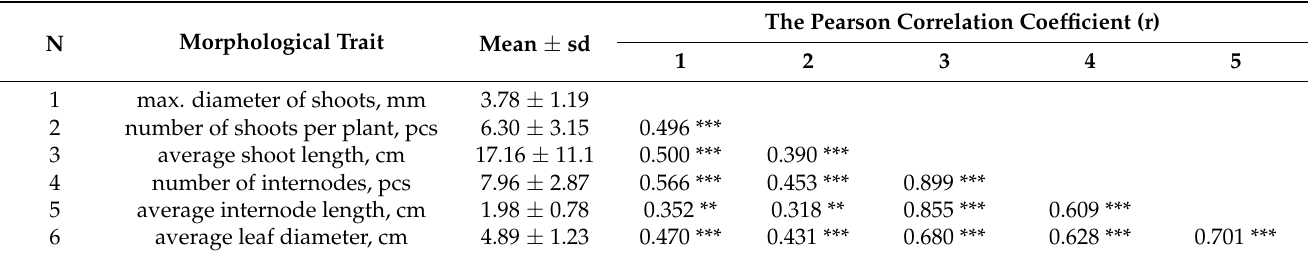
Table 3. Summary of morphological traits assessed for seedlings of cv. Dixie S1